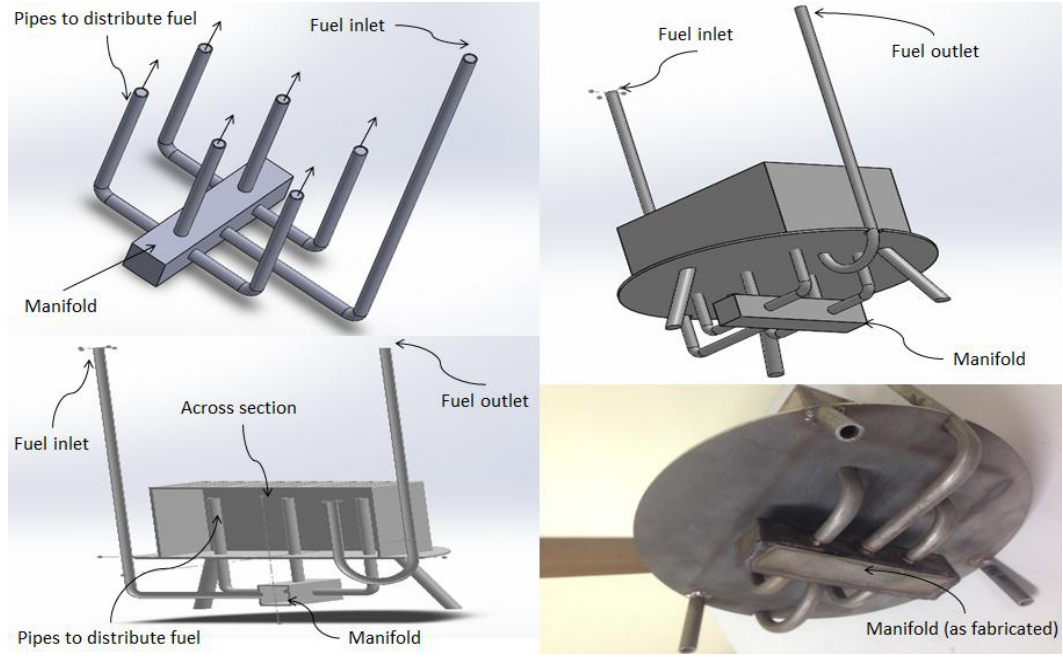
Figure 2. Schematic of a manifold two-dimensional (2D) configuration solid oxide fuel cell (SOFC) stack.